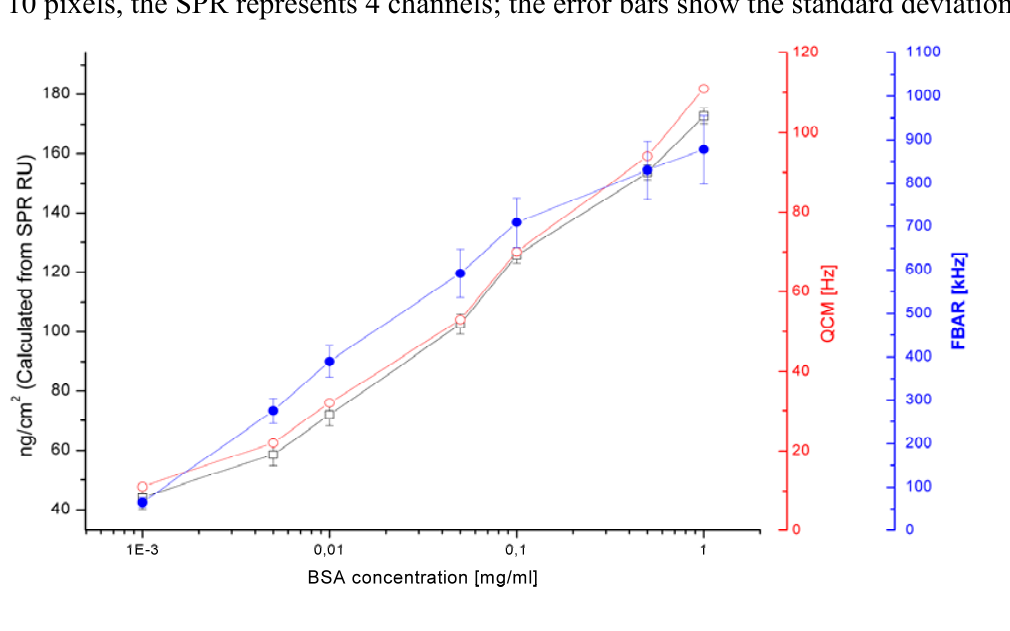
Figure 2. Titration curves for bovine serum albumin as measured with QCM (  ), CMOS- integrated FBAR (  ) and SPR (  ). The curve for the FBAR measurement is the average of 10 pixels, the SPR represents 4 channels; the error bars show the standard